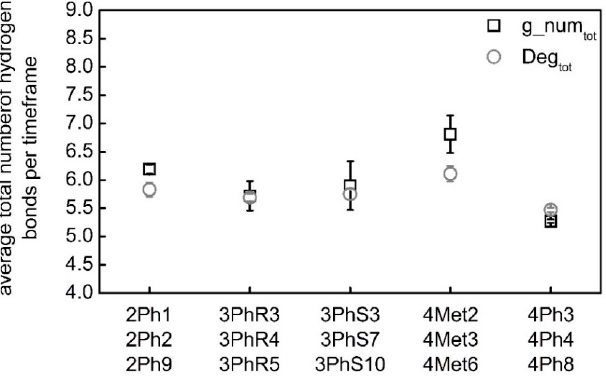
Figure 3. Comparision of the average total number of hydrogen bonds per timeframe derived from ChemNetworks (Deg tot ) and Gromacs (g_num tot ) analysis for different molecules.